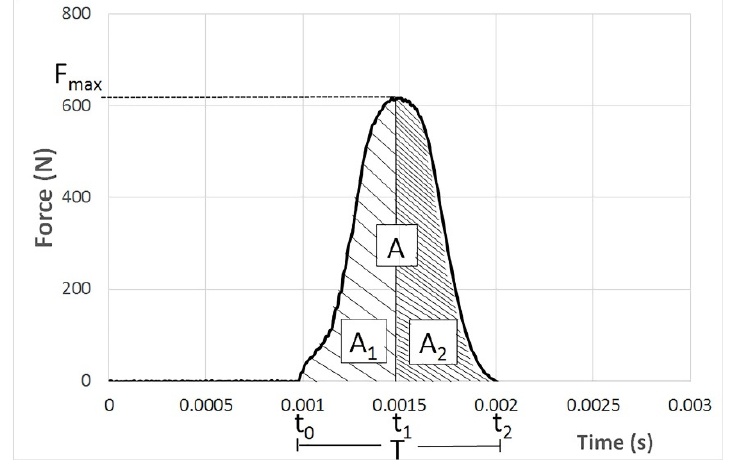
Figure 6. Example of force–time diagram in impact